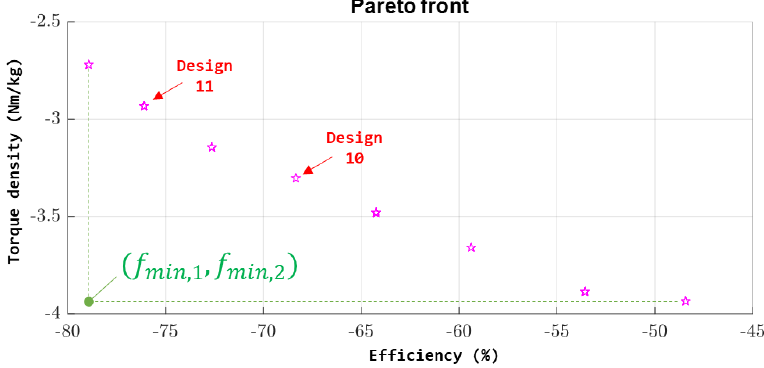
Figure 8. Pareto front of the design method.